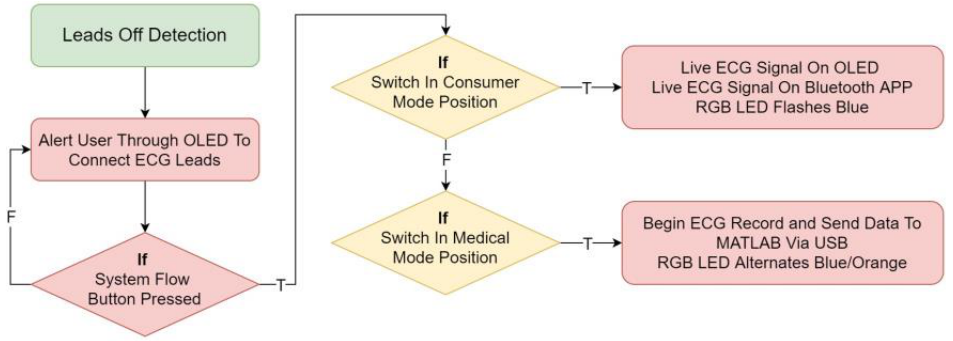
Figure 6. Lead off detection subroutine. “F” represents the action if the condition is false, while “T” represents the action if the statement is true.